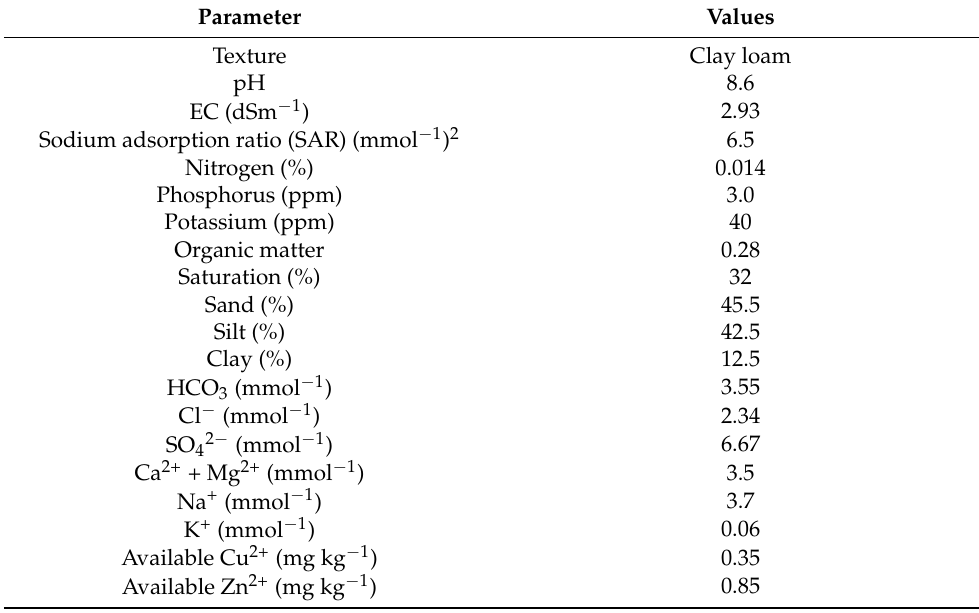
Table 1. Physicochemical soil characteristics used in the plant growth promotion